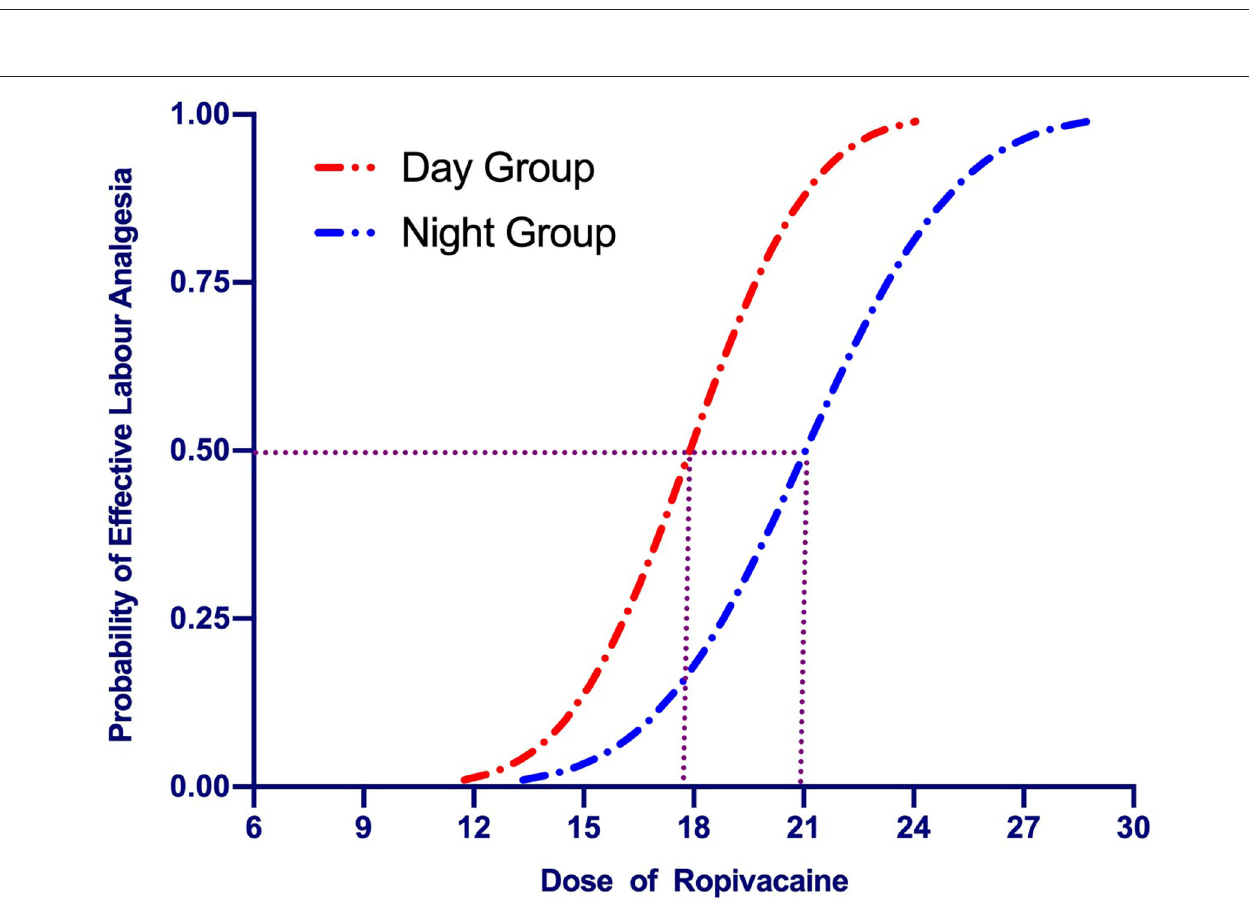
FIGURE 3 | Dose-response curves of epidural ropivacaine for labor analgesia plotted from estimated probabilities of effective response (1% to 100) vs. the corresponding dose of the initial bolus derived from probit regression analysis. The median effective dose (ED 50 ) of epidural ropivacaine for labor analgesia was 17.9 (95% CI: 15.8–20.0) mg in the Day Group vs. 21.0 (95% CI: 18.9–23.4) mg in the Night Group.